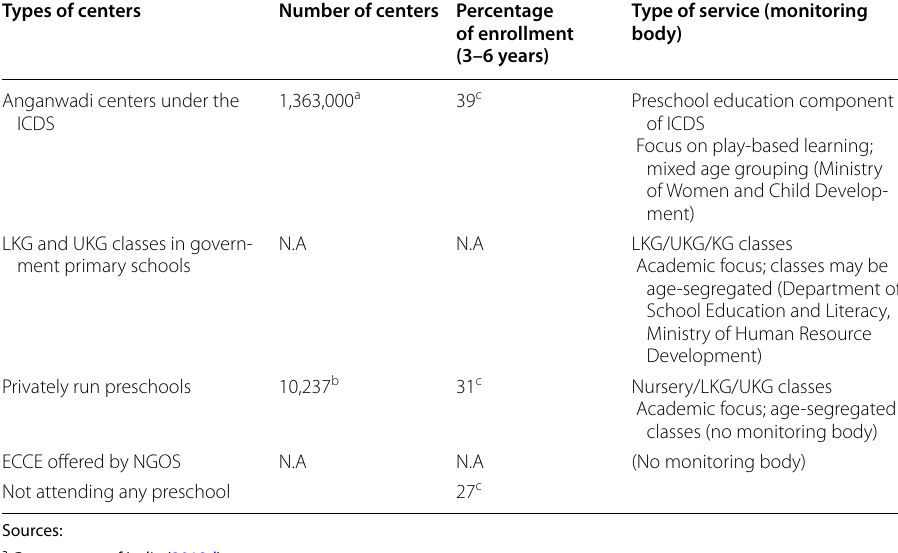
Table 1 Number of early childhood centers and estimated enrollment